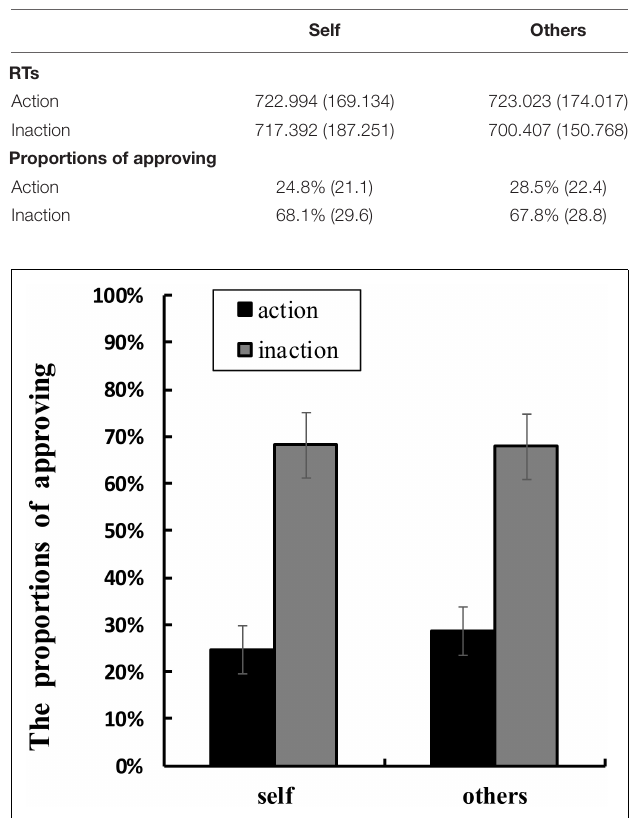
FIGURE 4 | Mean proportions of approving (%) in each condition. The error bars show ± 1 standard error.